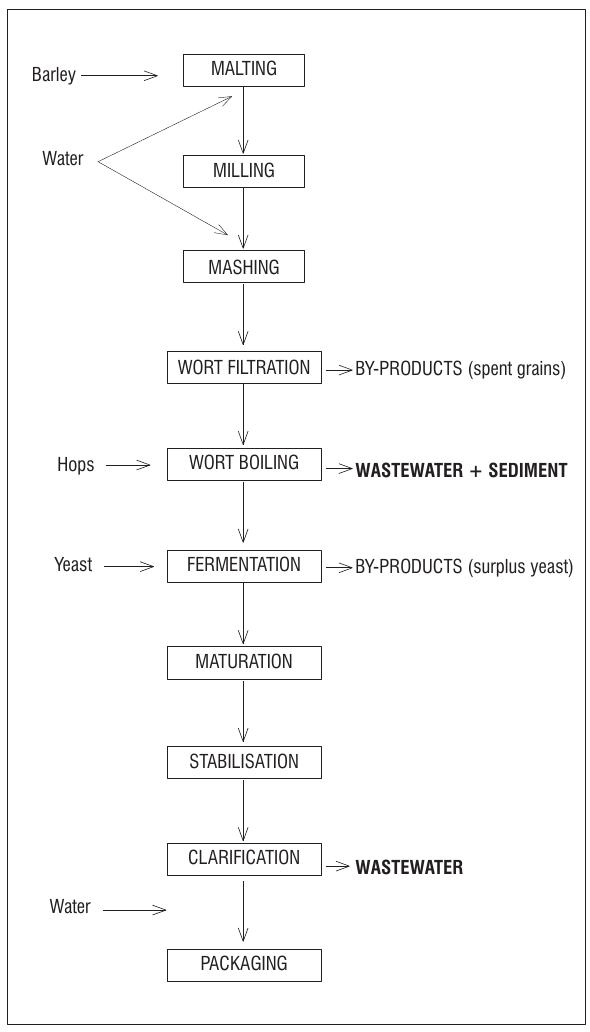
Technological processes in brewery operations Analysis of various treatment